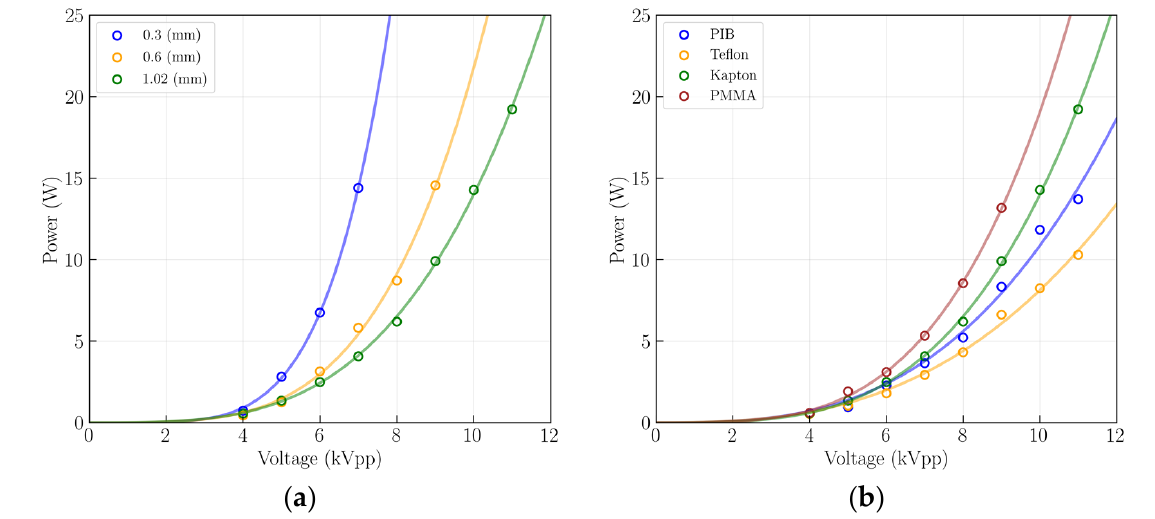
Figure 4. Power consumption curves obtained for different input voltage levels and a frequency of 24 kHz for dielectric layers made of ( a ) Kapton with different thicknesses; ( b ) different materials with 1 mm of thickness.